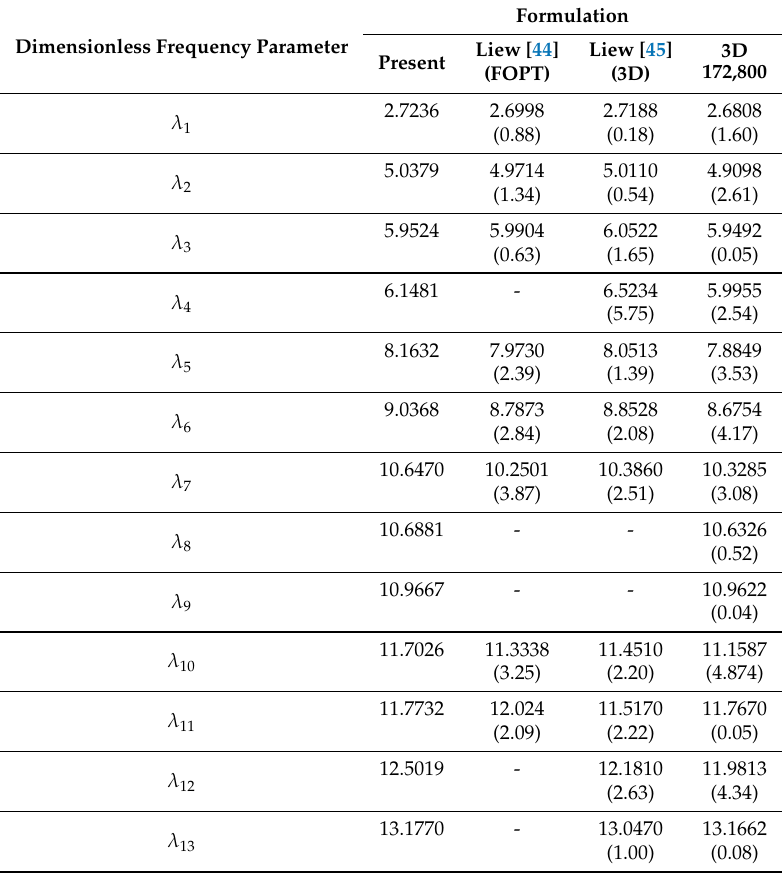
Table 7. Comparison of results for a square plate of ratio b / h = 10 and SCSC boundary conditions.